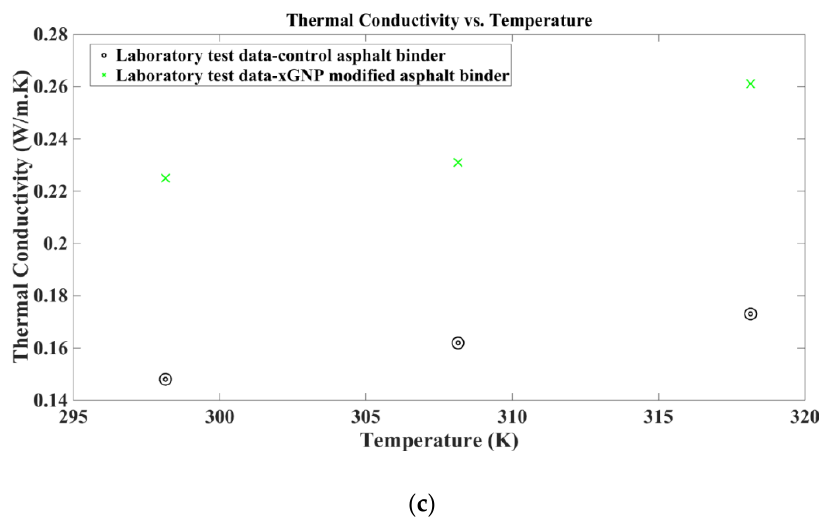
Figure 9. Thermal conductivity test apparatus and results. ( a ) KD2 Pro thermal conductivity tester in the laboratory; ( b ) the chamber for temperature control in the thermal conductivity test; ( c ) Thermal conductivity results of the control and xGNP modified asphalt binders.